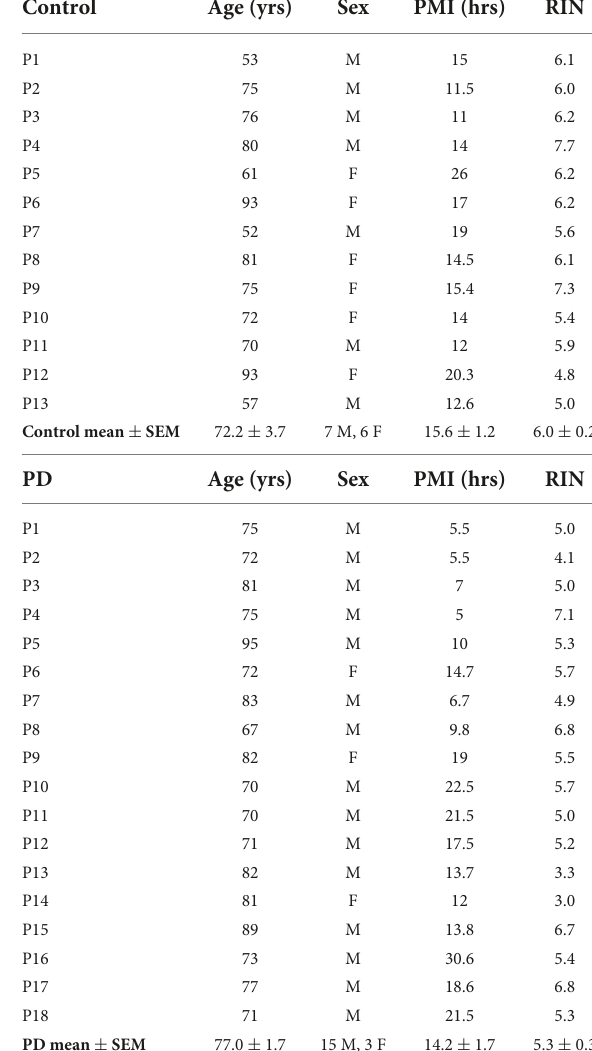
TABLE 2 Subject and tissue characteristics: